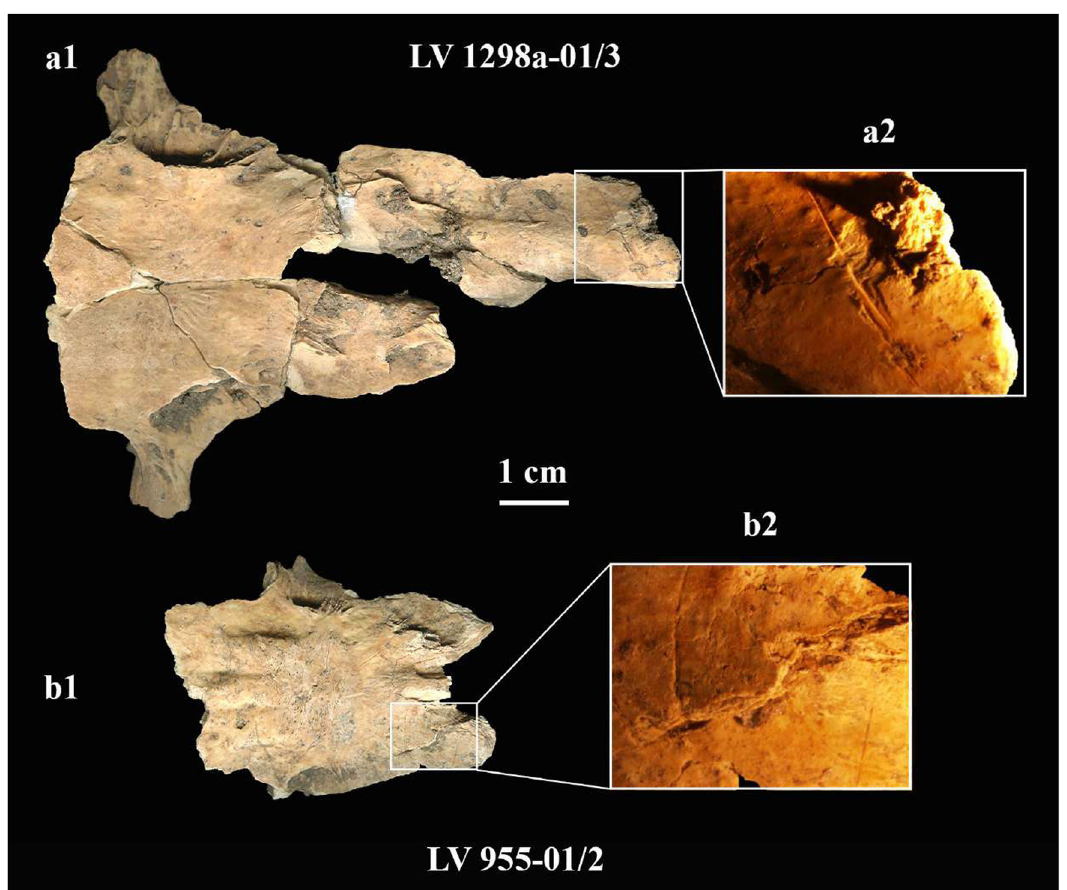
Figure 13: LV 1298a - 01/3: ( a1 ) fragment of a Russian sturgeon parasphenoid ( found between superimposed fl oors of buildings 21, 22, and 30, transitional phase ) , with 2 – 3 long diagonal cut marks on the ventral side, 7.5 × magni fi cation ( a2 ) ; LV 955 - 01/2: ( b1 ) fragment of a Russian sturgeon parasphenoid ( sq. c/I – III, spit X, Early Neolithic ) , with a long transverse cut mark on the ventral side, 10 × magni fi cation ( b2 ) ( Figure 9.16 in Ž ivaljevi ć , 2017 )